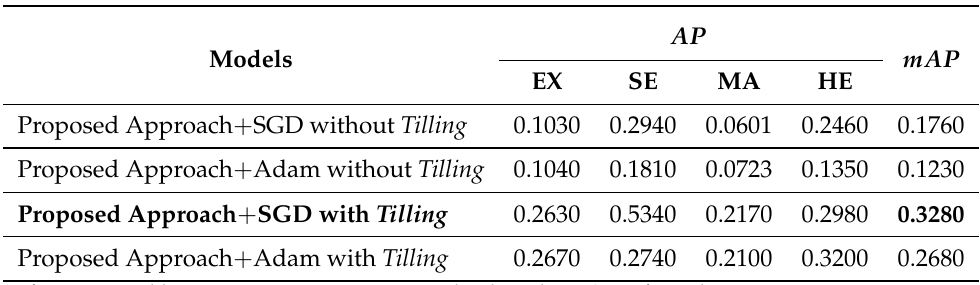
Table 10. Results obtained by the proposed approach with Tilling and the SGD and Adam optimizers with the metrics AP and mAP for the Intersection over Union limit of 0.5 in the validation set of the Indian Diabetic Retinopathy Image Dataset